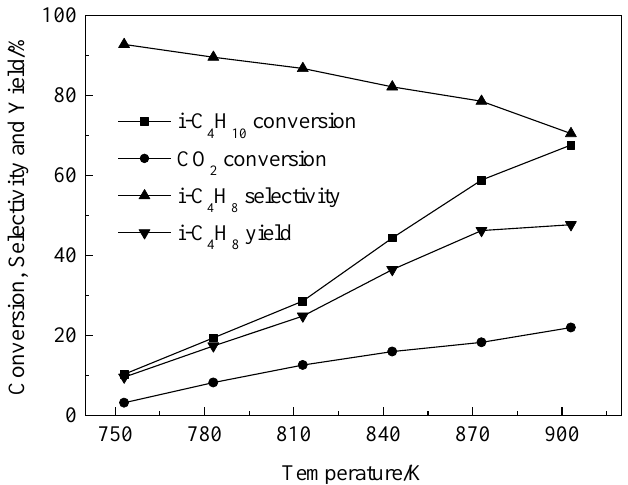
Figure 4. Effect of temperature on dehydrogenation of isobutane to isobutene with CO 2 over VO x /MSU-1. Reaction conditions: 12 wt. % VO x /MSU-1 0.2 g; total flow rate 24 mL/min; V(CO 2 ):V( i -C 4 H 10 ) = 3:1.